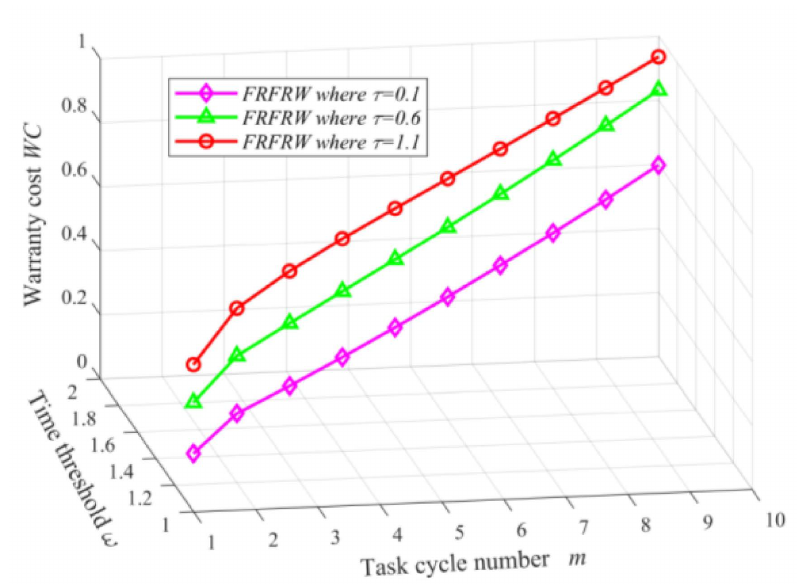
Figure 1. The impacts of τ on the warranty cost of the FRFRW.